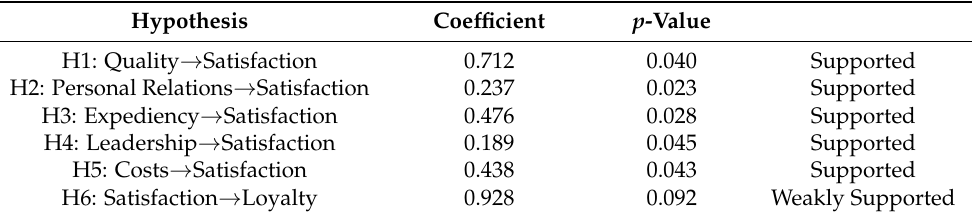
Figure 2. The proposed model. Source: authors results. Table 3. The results of hypotheses